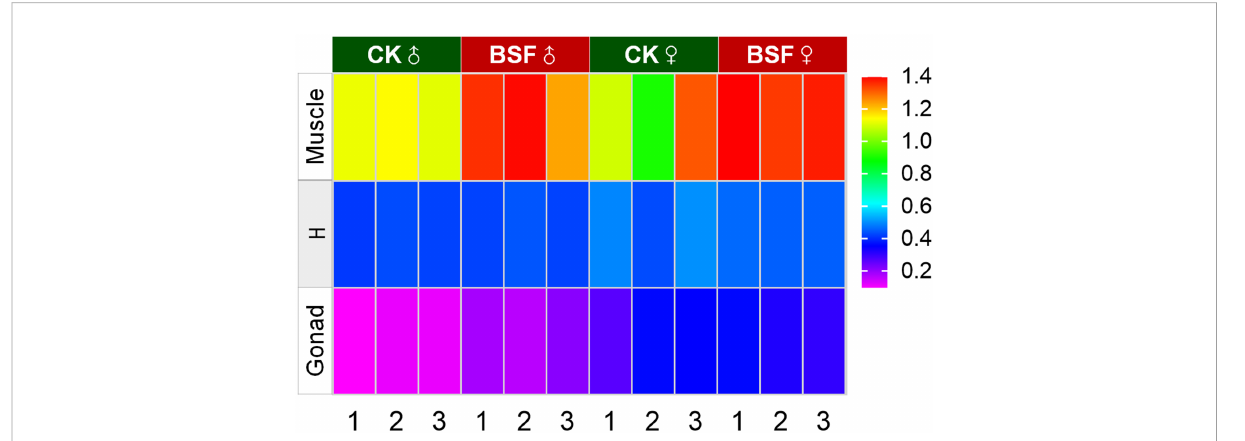
FIGURE 6 Effects of BSFL feeding on sweetness evaluation indices in edible tissues of mitten crabs. SWT heatmap indicating the effects of various sweet amino acid contents on sweetness. CK, control group; BSF, experimental group; ♂ , female crabs; ♀ , male crabs. n =